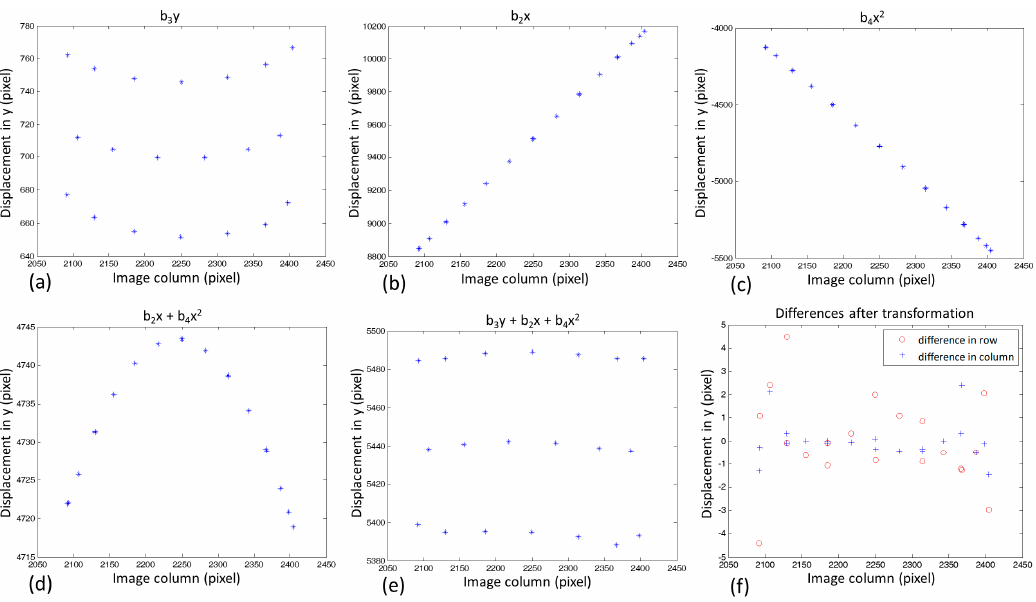
Figure 6. Behaviour of the polynomial terms in equation y’ (individually and combined) as a function of the image columns in ( a – e ), and the differences in the coordinates after geometric transformation in ( f ).